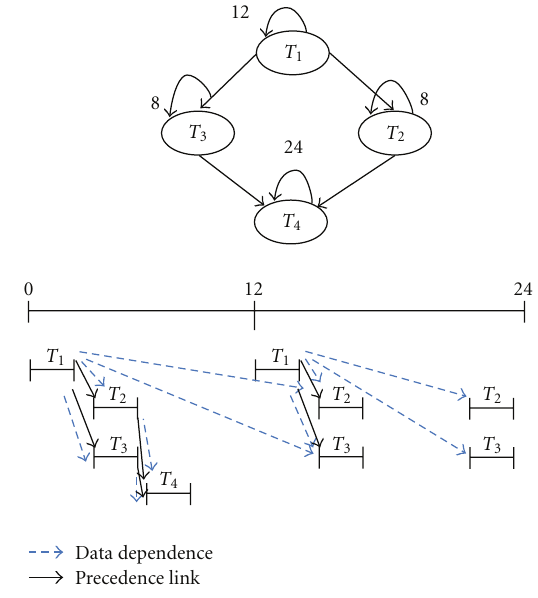
Figure 1: The targeted acyclic task